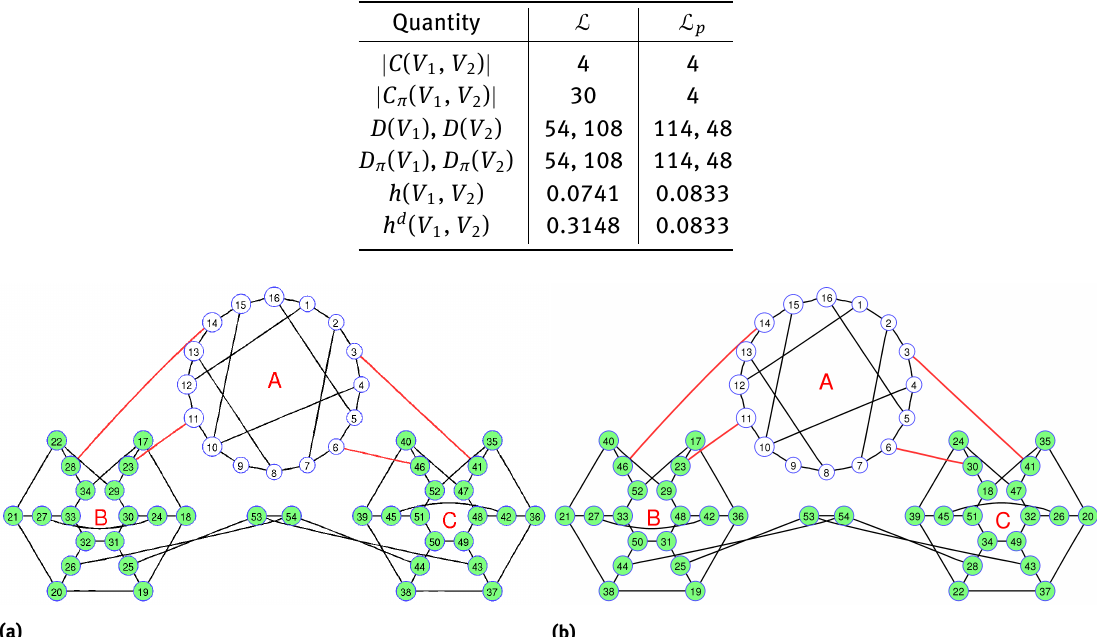
Figure 5: Ellingham-Horton 54-graph. Shown is the result of the spectral bisection method described in Section 4 using L p . The resulting partition is shown as V 1 (colored vertices), V 2 (non-colored vertices) and the partition boundary (red edges). (a) G : | C ( V 1 , V 2 ) | = 4 , D ( V 1 ) = 114 , D ( V 2 ) = 48 . (b) π ( G ) : | C π ( V 1 , V 2 ) | = 4 , D π ( V 1 ) = 114 , D π ( V 2 ) = 48